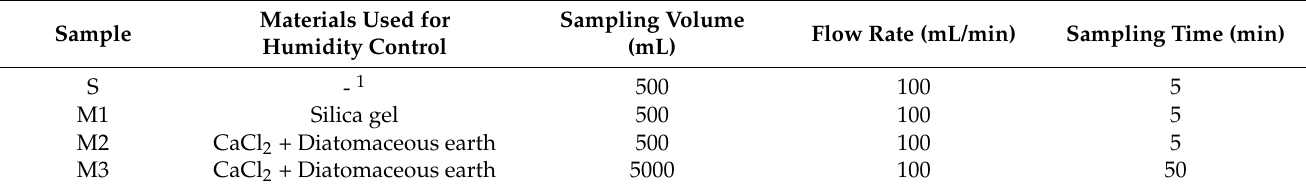
Table 1. Experimental setup of humidity control for different